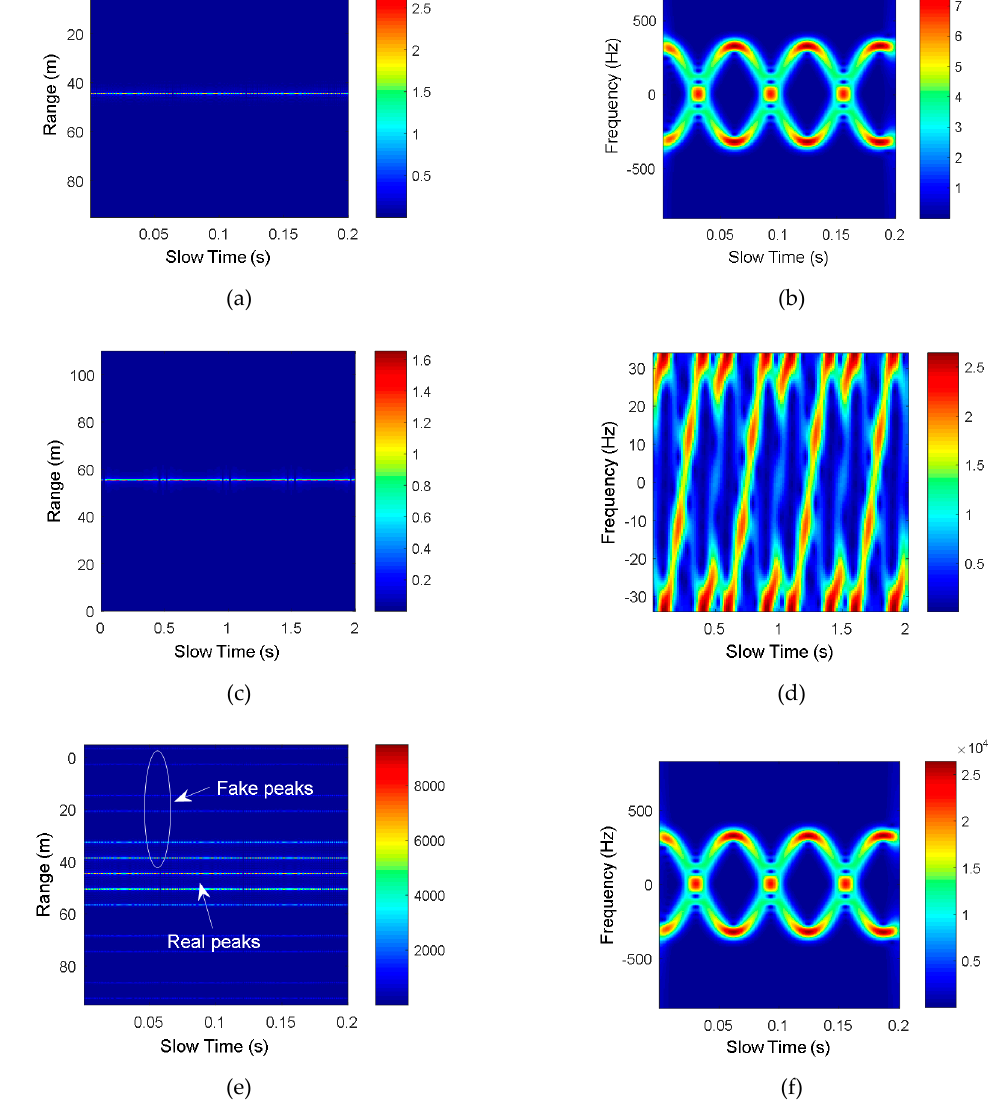
Figure 4. Micro-Doppler extraction results. ( a ) Range slow-time image of the complete pulse echo. ( b ) Time-frequency image of the complete pulse echo. ( c ) Range slow-time image of the swept frequency echo. ( d ) Time-frequency image of the swept-frequency echo. ( e ) Range slow-time image of the ITR echo. ( f ) Time-frequency image of the interrupted transmitting and receiving (ITR) echo.